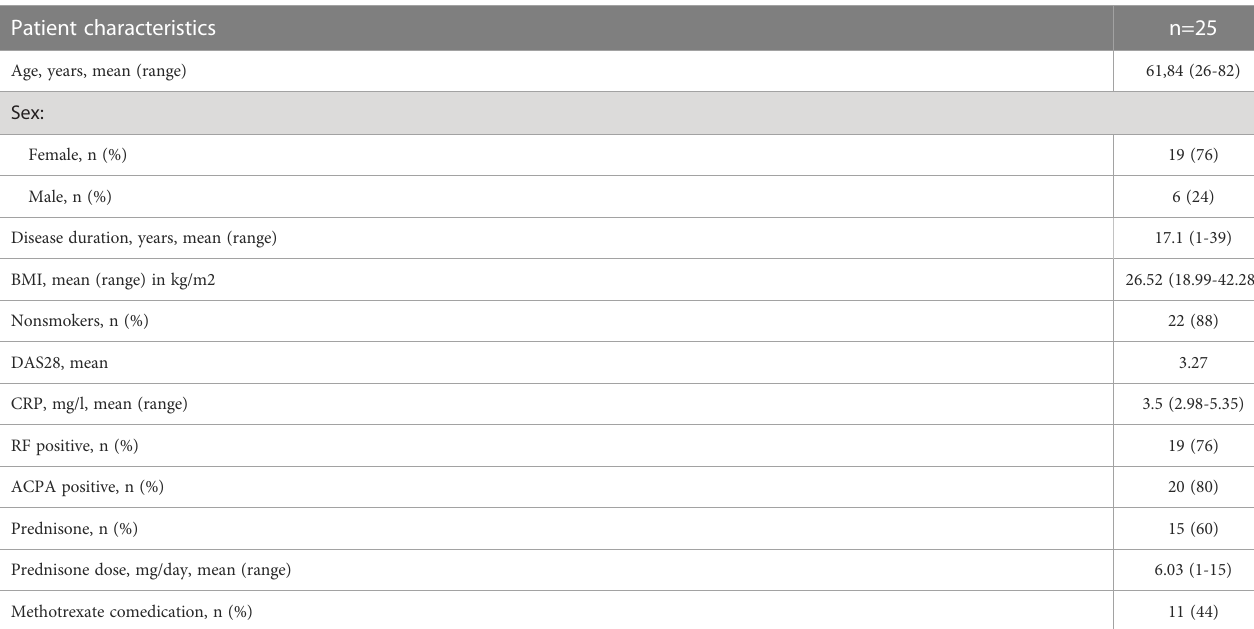
TABLE 1 Characteristics of 25 rheumatoid arthritis patients treated with JAK inhibitors. Patient